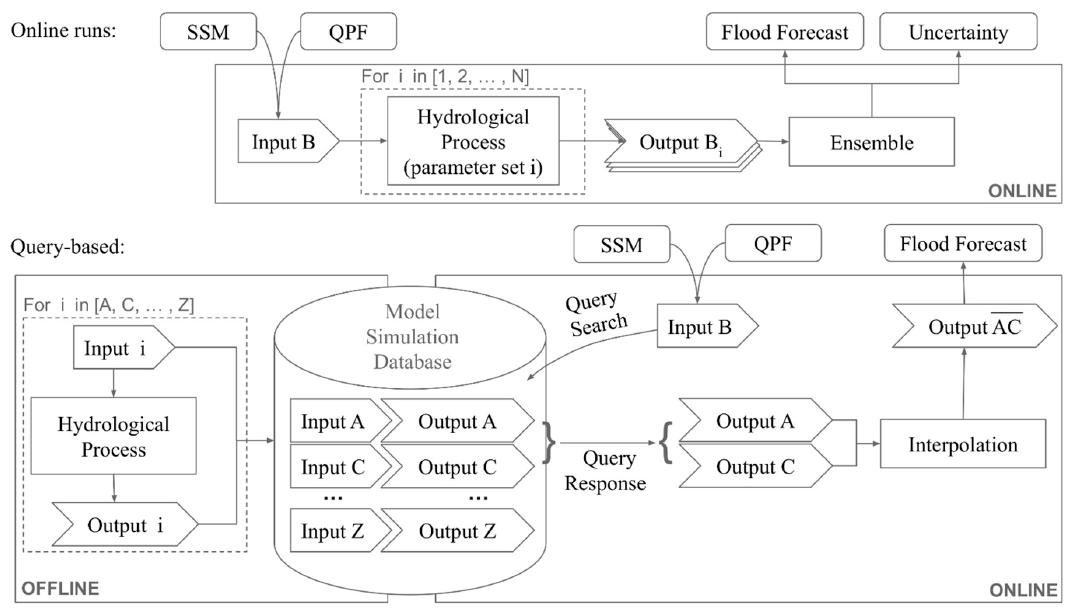
Figure 4. Comparison diagram of hypothetical online-run and query-based systems, both driven by SSM and QPF values.